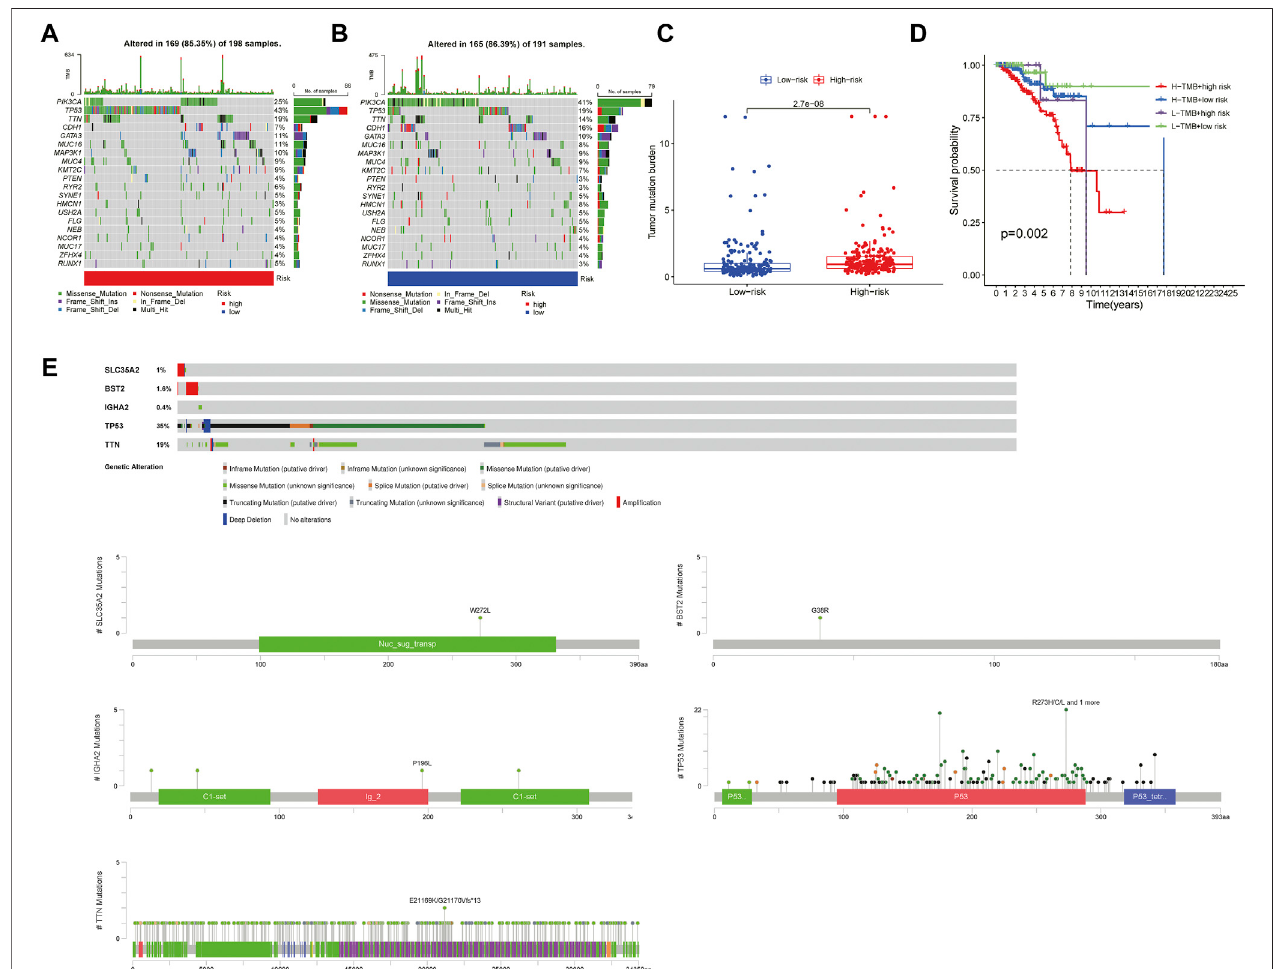
FIGURE 10 | Mutation analysis in the high-risk group and the low-risk group (A,B) . The waterfall chart showed the mutation frequency of the high- and low-risk groups (C) The box plot re fl ected the correlation between the risk score and the TMB scores (Wilcoxon test, p < 0.05) (D) The Survival curve showed the joint effect of TMB score and risk score on the prognosis of patients (log rank test, p < 0.05) (E) The plot showed the mutation type of key genes and functional domains where the mutations were